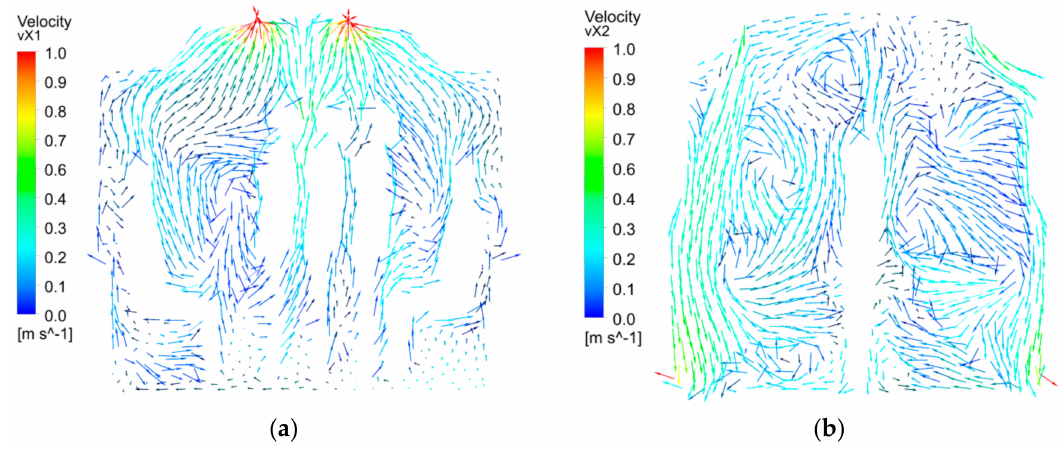
Figure 6. Velocity fields, Case 3, plane X1 ( a ) and plane X2 ( b ).